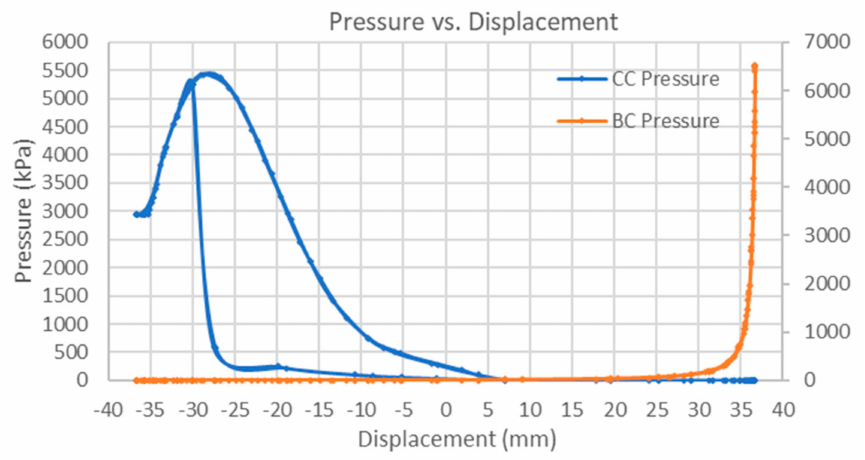
Figure 10. Operation with load: pressure vs. displacement profile for CF =